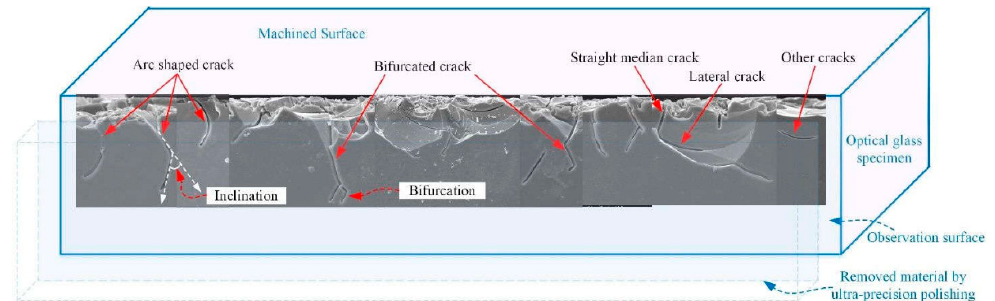
Figure 4. Subsurface cracks observed in experiments.